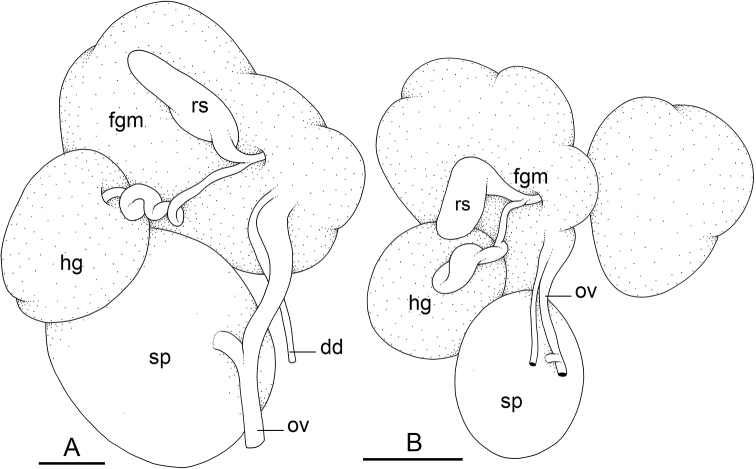
Posterior, hermaphroditic (female) reproductive system, Peronia
griffithsiA holotype, Mauritius [3157 H] (MNHN-IM-2000-35265) B Indonesia, Kei Islands [2936] (UMIZ 00176). Scale bars: 1 mm (A), 2 mm (B). Abbreviations: dd deferent duct, fgm female gland mass, hg hermaphroditic gland, ov oviduct, rs receptaculum seminis, sp spermatheca.